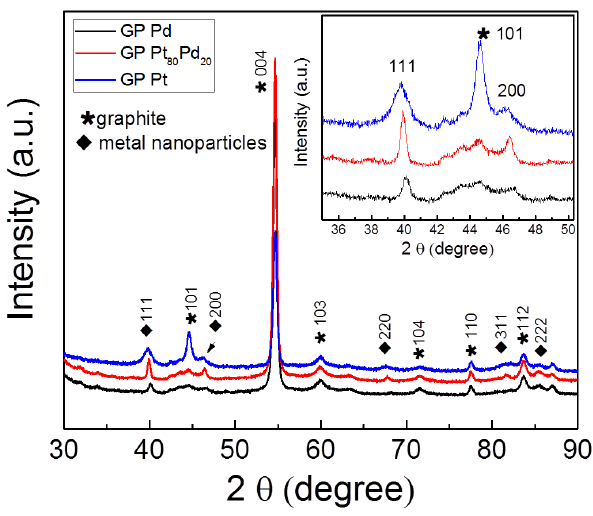
Figure 4. XRD patterns of platinum, palladium, Pt 80 Pd 20 nanoparticles supported onto graphene paper.